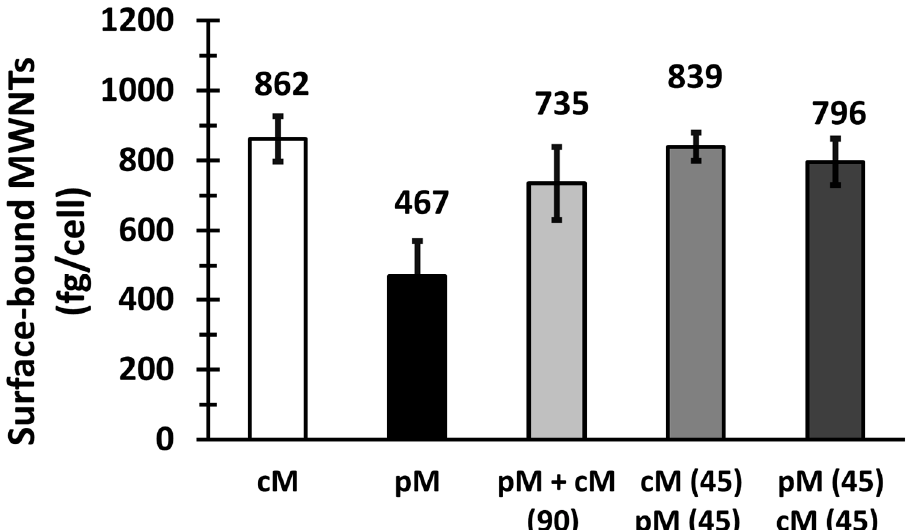
Figure 4. Test for additive binding of BSA-cMWNTs and BSA-pMWNTs to cells. Equivalent numbers of RAW 264.7 cells were seeded in 6-well plates and incubated at 37 ◦ C under standard cell culture conditions for 24 h prior to the experiment in preparation for the additive binding studies as described in Methods. Cells were exposed to serum- and sodium bicarbonate-free media containing either 100 µ g/mL BSA-pMWNTs or BSA-cMWNTs (labelled pM and cM in the graph) followed by incubation at 4 ◦ C for 90 min to establish the amount of each bound when separate. Additive binding was tested by exposing the cells simultaneously to both BSA-cMWNTs and BSA-pMWNTs for 90 min. In a slightly different experimental design, the cells incubated with either BSA-cMWNTs or BSA-pMWNTs at 4 ◦ C for 45 min, washed, and incubated with BSA-pMWNTs or BSA-cMWNTs, respectively, at 4 ◦ C for 45 min for a total incubation time of 90 minutes. Surface-bound MWNTs were extracted and quantified using the SDS-PAGE method. The numbers above the bars are the mean femtograms of MWNTs/cell, and each data point is the mean of ≥ 3 independent experiments ± SD.